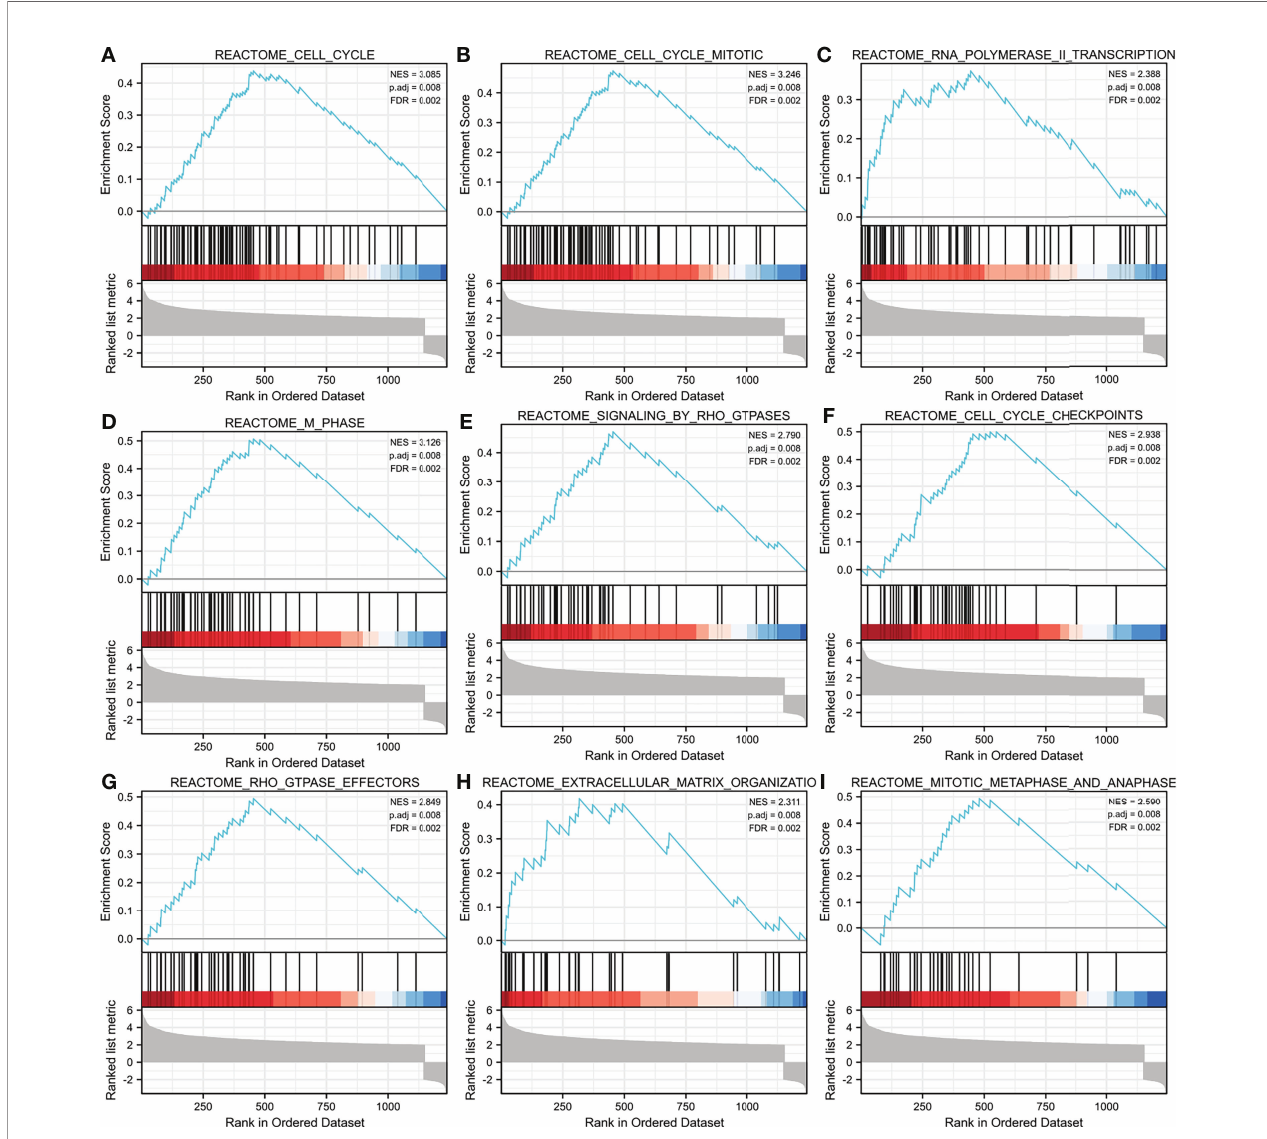
FIGURE 6 | GSEA enrichment analysis results. cell cycle (A) ,cell cycle mitotic (B) , RNA polymerase II transcription (C) , M phase (D) , signaling by RHO GTPases (E) , cell cycle checkpoints (F) , RHO GTPase effectors (G) , extracellular matrix organization (H) , mitotic metaphase and anaphase (I) were enriched mainly in ASF1B- related gliomas. NES, normalized enrichment score; FDR, false discovery